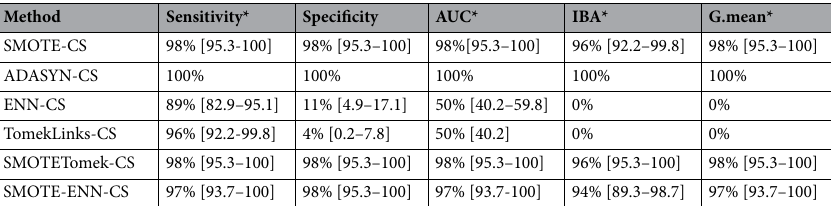
Table 1. A Comparison between class-balancing methods using clinical significance features selection (CS) and random forest model with (*Confidence Interval “CI